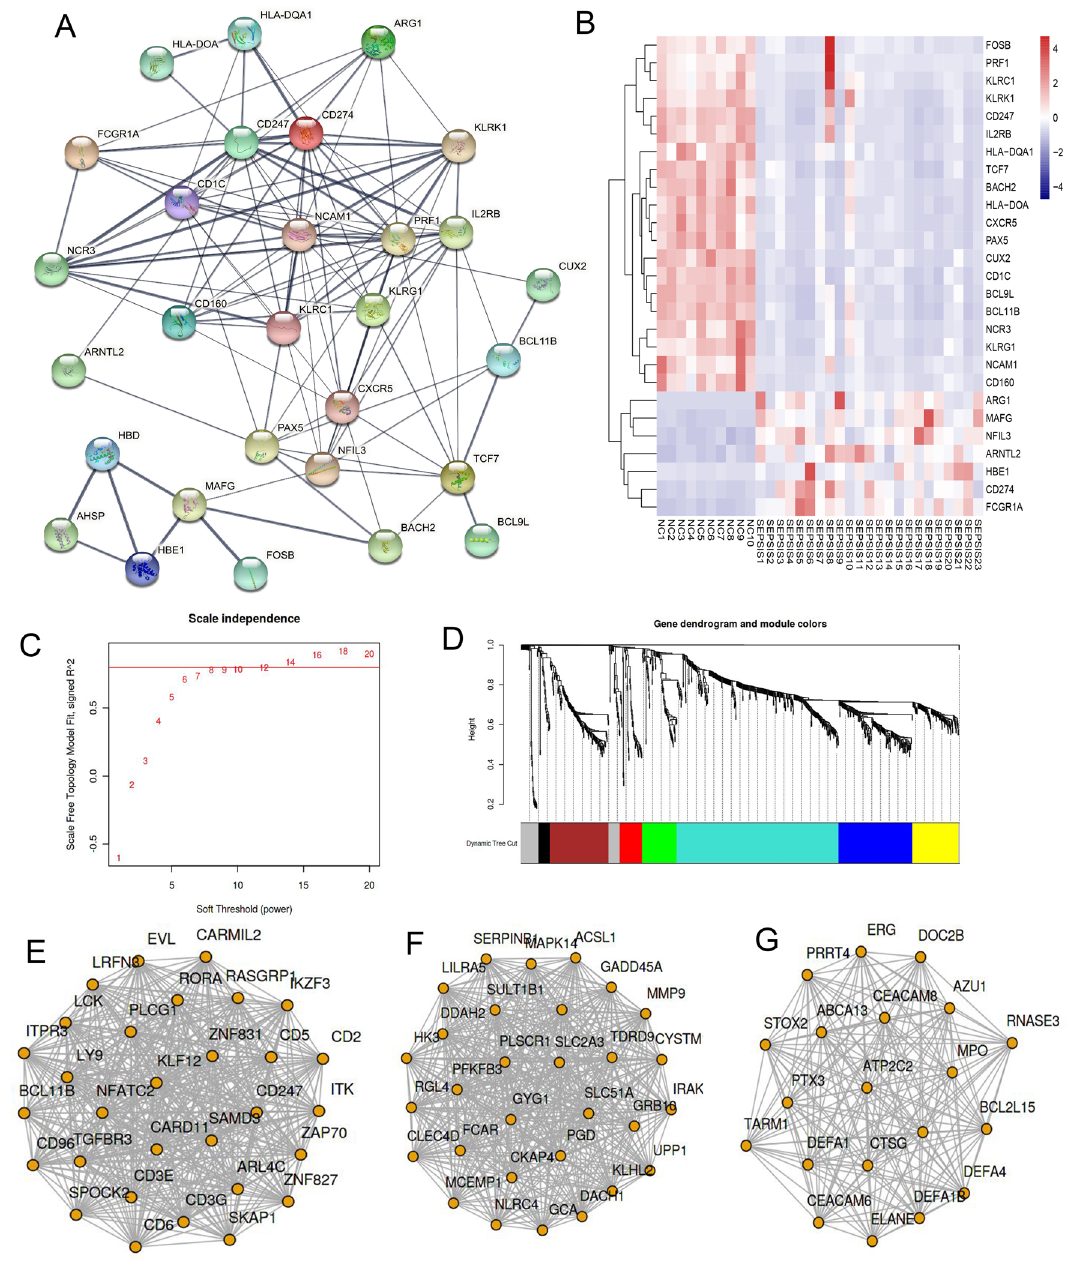
Figure 3. PPI and WGCNA plot and heatmap of pivotal gene expression. ( A ): PPI module plot of immune- related key genes. PPI analysis showed widely connection of immune-related genes, among which CD160, CD247, BCL9L, and BCL11B are located in the center of the network. ( B ): Heatmap of pivotal gene expression in PPI modules. Up-regulated genes are labeled as red; down-regulated genes are labeled as blue, and sample number at the bottom, gene names at right, and the shades of color indicating expression levels. ( C ): The soft threshold was 8 by WGCNA screening. ( D ): Visualization of cluster analysis of different modules.The blue, yellow and green modules were consistent with the clinical presentation. ( E – G ): Co-expression network of potential core genes in module 2 (blue), module 4 (yellow) and module 5 (green),